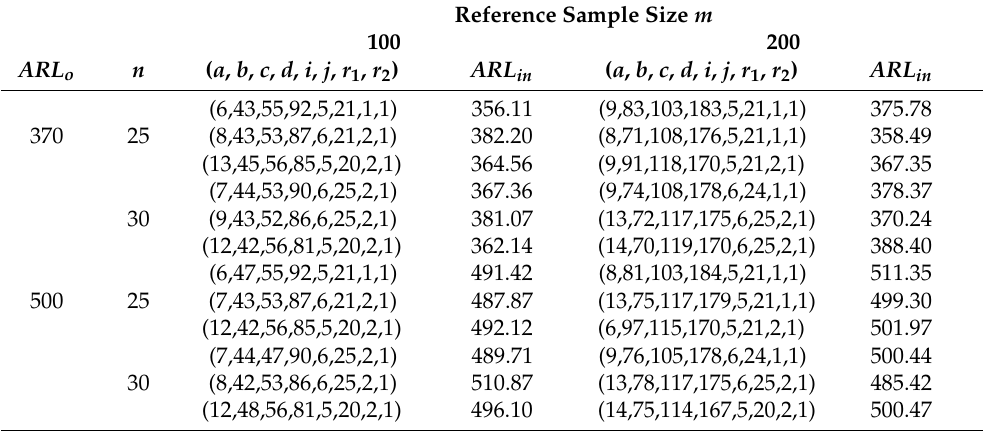
− , C 3 − and C 4 − charts for a given 2 2 2